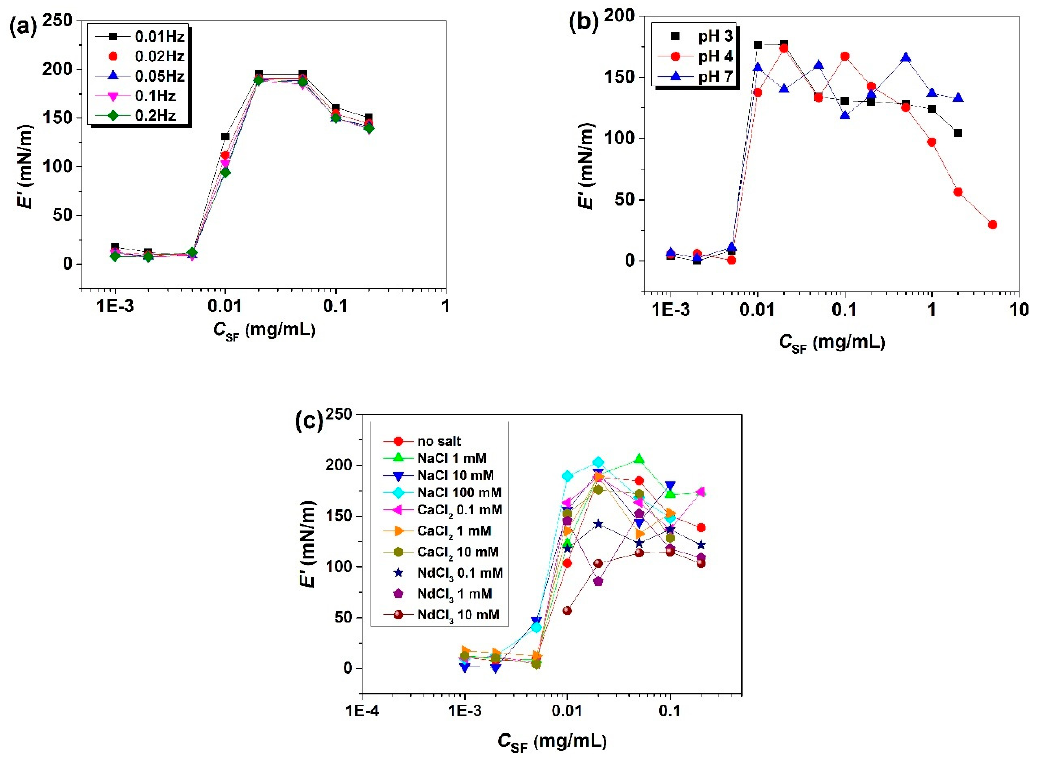
Figure 4. Influences of the solution conditions on the surface dilatational elastic modulus ( E’ ) of the SF layers formed at the air/water interface after reaching adsorption equilibrium: ( a ) influences of C SF ; ( b ) influences of pH at 0.1 Hz; ( c ) influences of salts at 0.1 Hz (taken from [34 − 36]).